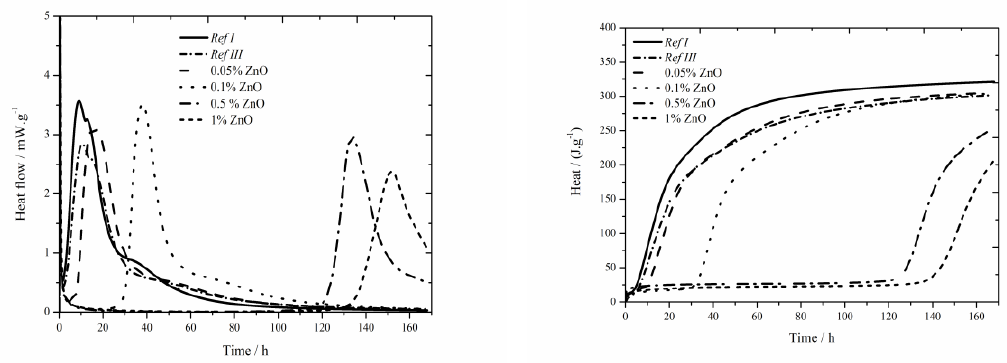
Figure 6. Isothermal curves for ZnO samples.